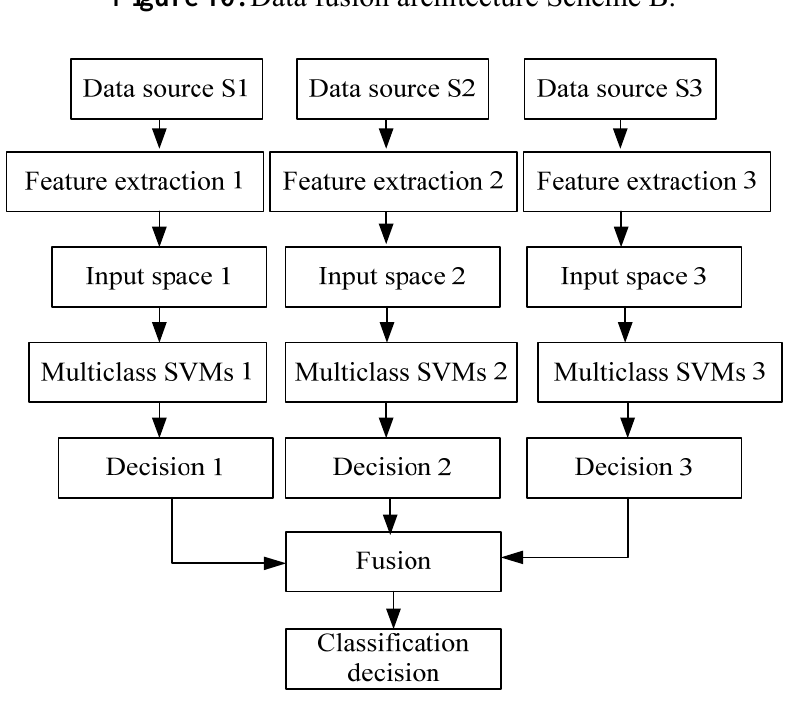
Figure 10. Data fusion architecture Scheme